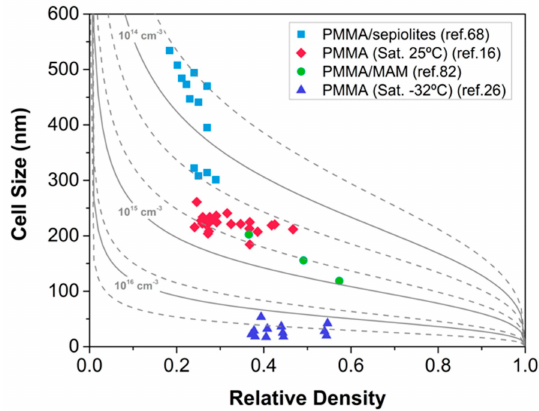
Figure 10. Relative density—cell size map. For the PMMA/sepiolites bimodal cellular materials [70], cell size plotted is that of the nanocellular region. Curves indicate regions of constant cell nucleation density according to Equations (1) and